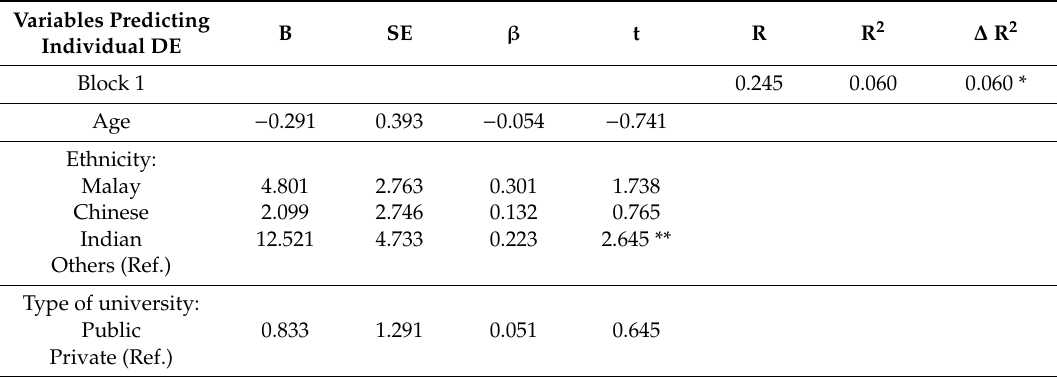
Table 4. Hierarchical multiple regression analyses for individual prediction of disordered eating (EAT-26) from body mass index, socio-demographic characteristics, and personal variables in males ( n =